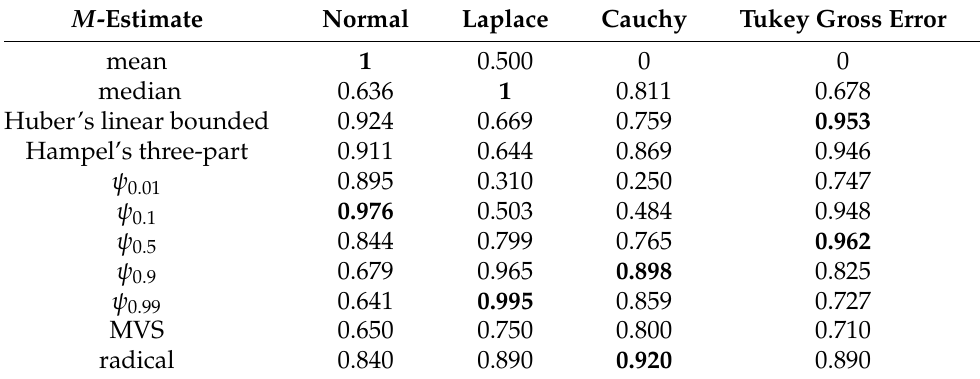
Table 1. Asymptotic efficiency (two best values are